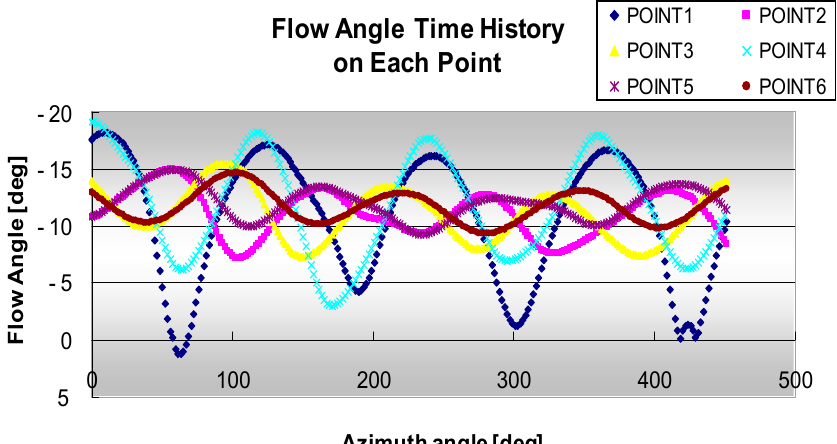
Figure 16. Flow angle time history on each nacelle anemometer position with varying azimuth angle.